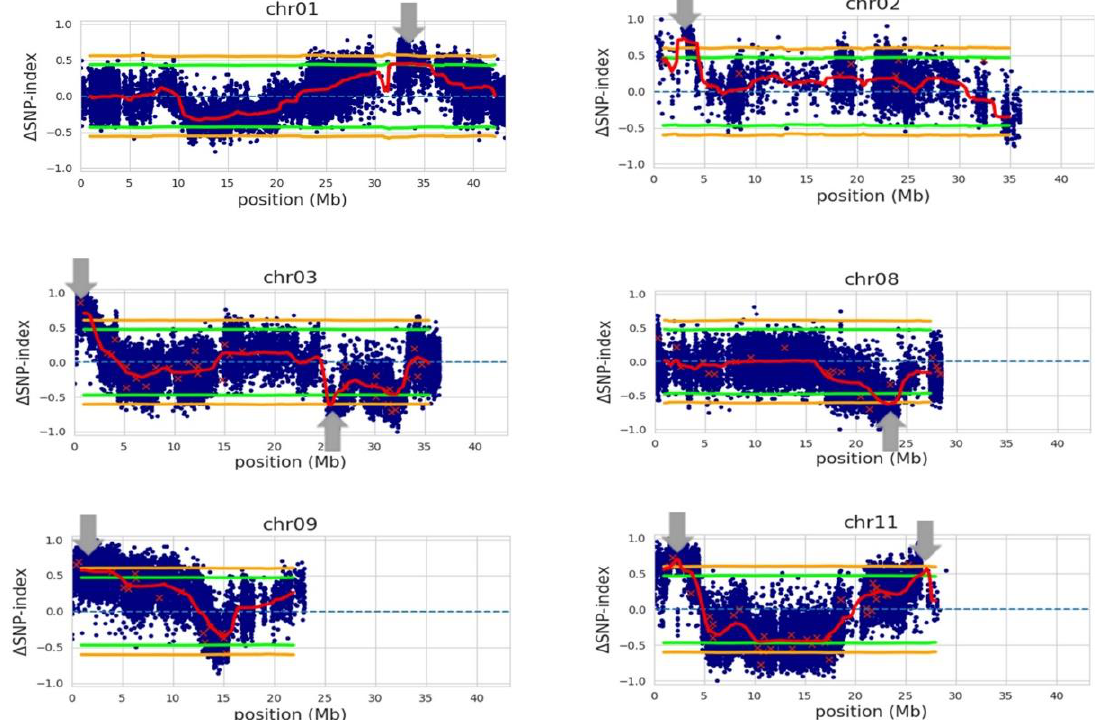
Figure 3. QTLs (indicated by gray arrows) associated with bacterial panicle blight (BPB), sheath blight (SB), and days to 50% heading (DTH) using Trenasse as the consensus reference genome. The blue dots correspond to individual SNP variants between two bulks, which represent ‘BPB/SB-susceptible and early DTH’ and ‘BPB/SB-resistant and late DTH’, respectively. The red ‘x’s indicate variants with low depth. The red lines represent the mean for ∆ SNP-indices. The green and orange lines are the 95% and 99% confidence intervals for the regions, respectively. Table 6. QTLs (p < 0.05) detected by QTL-seq associated with the resistance to BPB, SB and DTH using Trenasse as the reference genome.